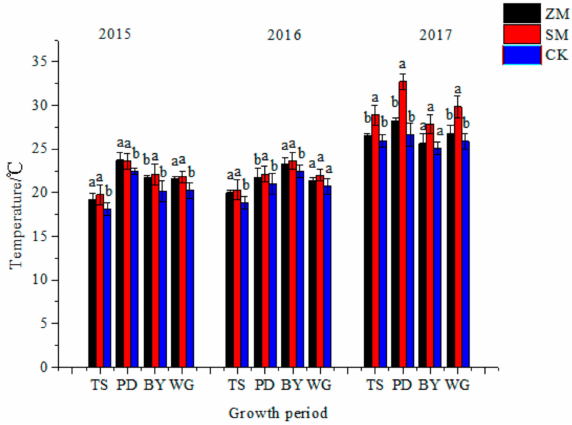
Figure 5. Changes of soil temperature in 0.1 m depth under di ff erent treatments.